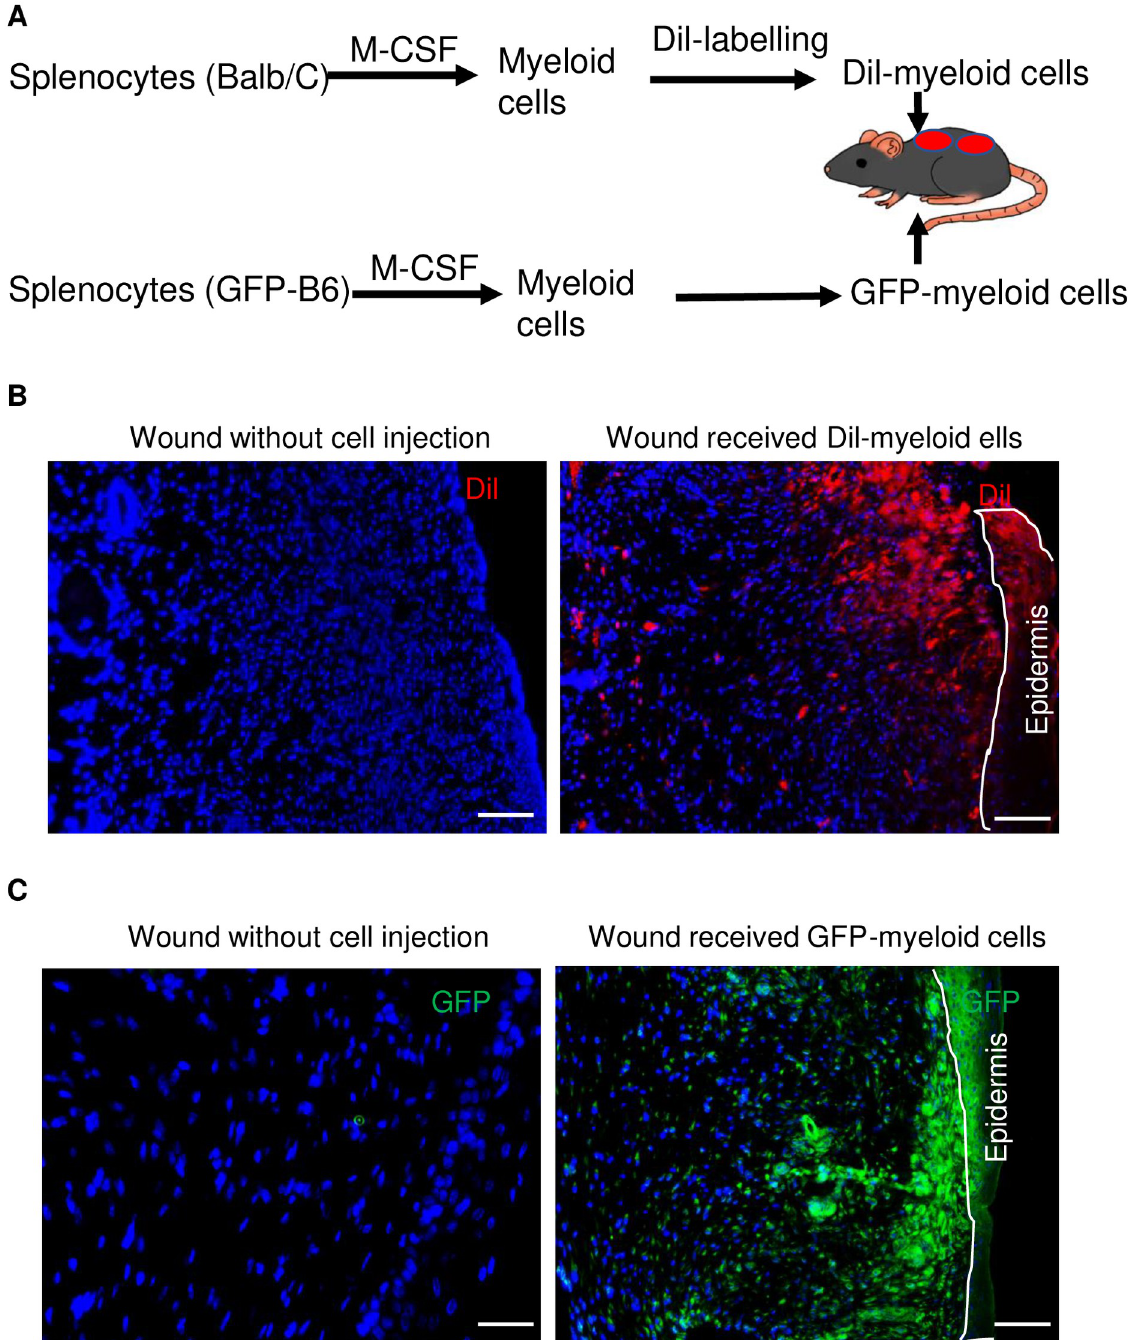
Fig 4. Distribution of injected splenocyte-derived myeloid cells in healed mouse skin. ( A ) Schematic figure of Dil-labeled or GFP- expressing mouse myeloid cell lineage tracing experiments. Splenocytes were isolated from spleens of Balb/C or C57BL/6-Tg (UBC-GFP) mice and cultured in a medium containing 5 ng/ml of M-CSF to generate myeloid cells. One million labeled cells were dermally injected into the healthy skin at one spot where was one centimeter far from the edge of wounds at the same time of skin injury. ( B ) Dil-labeled cells in wounded skin of mice received nothing (Left) or one million Dil-labeled splenocyte-derived myeloid cells (Right). ( C ) GFP-positive cells in wounded skin of mice received nothing (Left) or one million GFP-expressing splenocyte-derived myeloid cells (Right). Skins were stained with GFP antibody (green). DAPI (blue) was used as a nuclear counterstain. Scale bars in all images were 100 μ m.